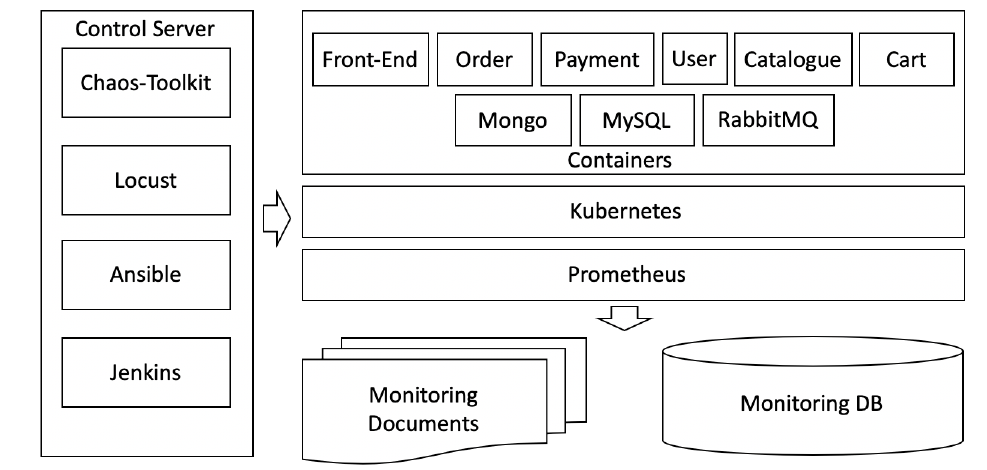
Figure 11. Deployment architecture of the whole experiment